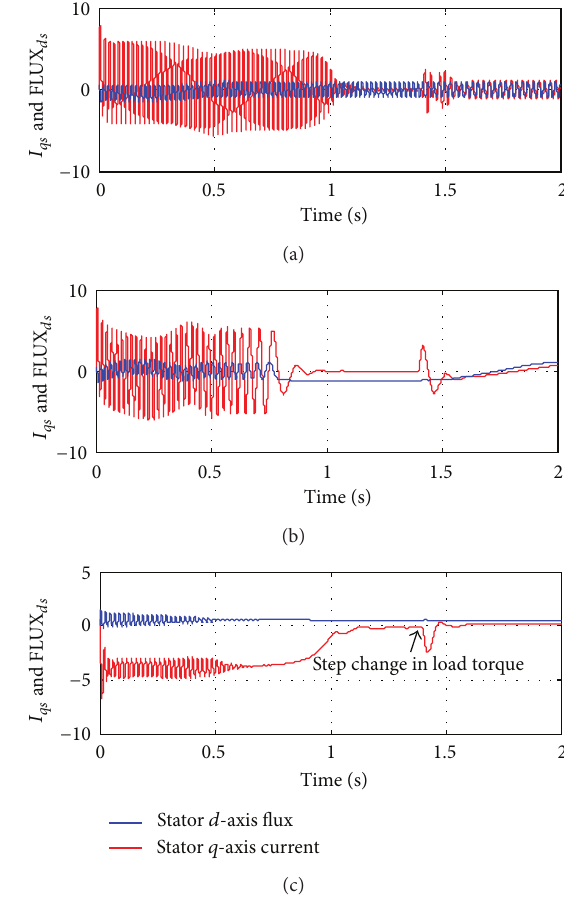
Figure 4: Simulated results of 𝑞 -axis stator current and 𝑑 -axis rotor flux in different rotating reference frames.